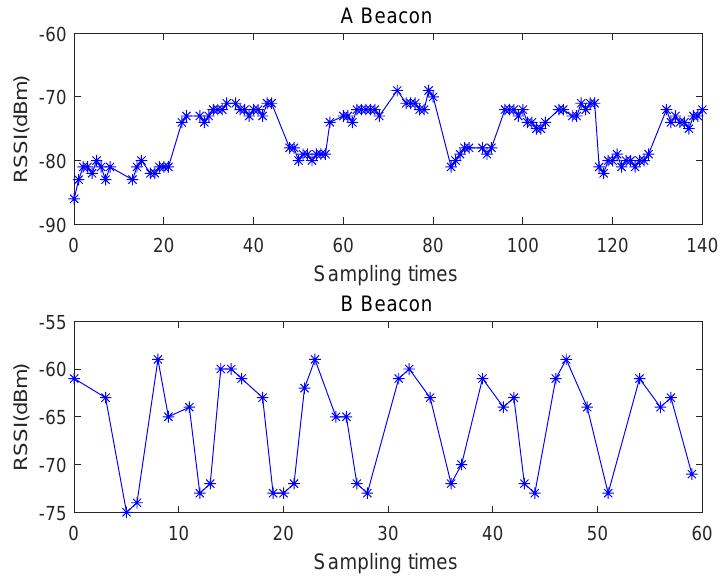
Figure 1. Bluetooth signal